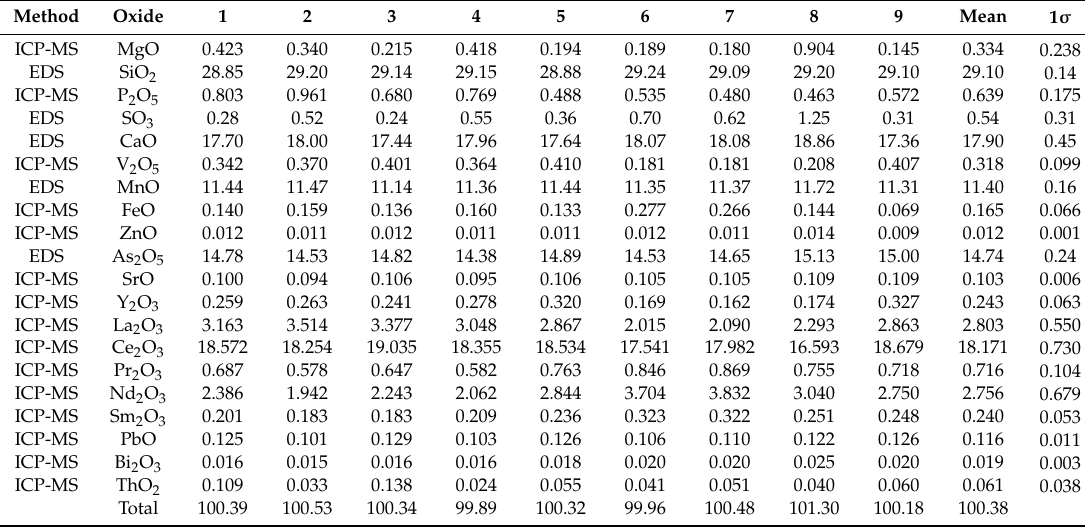
Table 2. Chemical data (in wt.%) for